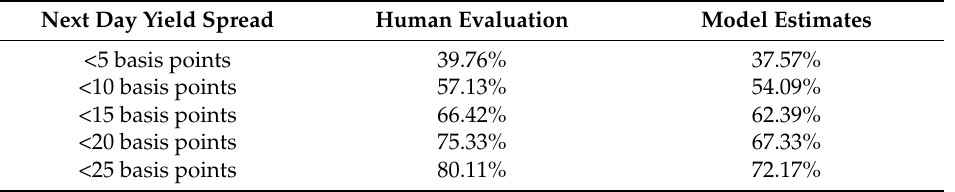
Table 5. Next day trading error